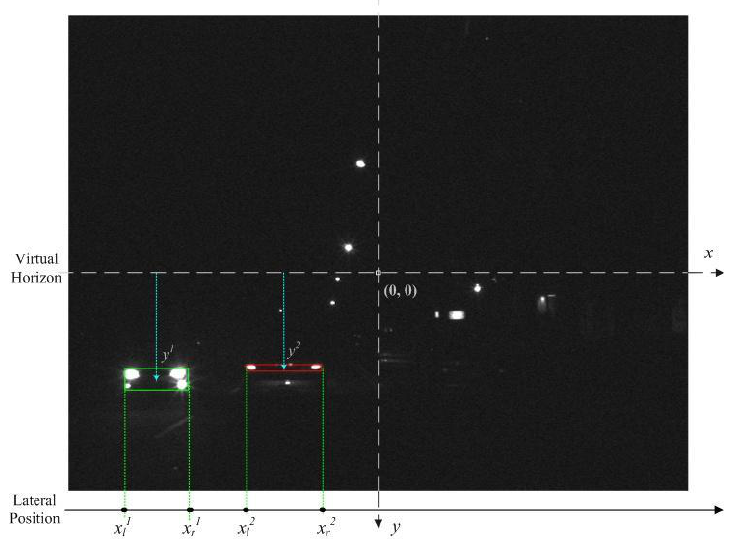
Figure 6. The spatial clustering process of the bright components of